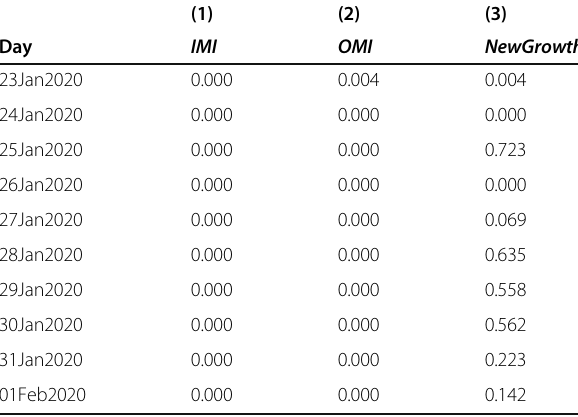
Table 3 Empirical p-values for IMI , OMI , and